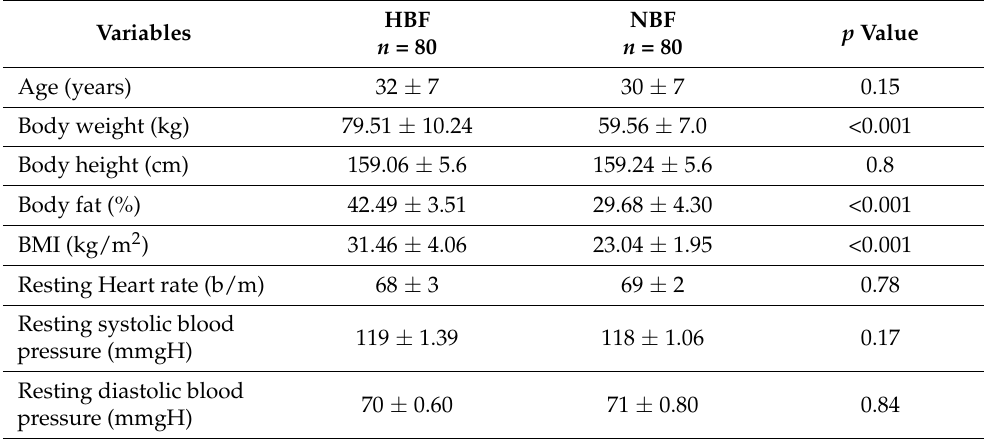
Table 1. Physical characteristics of participants.